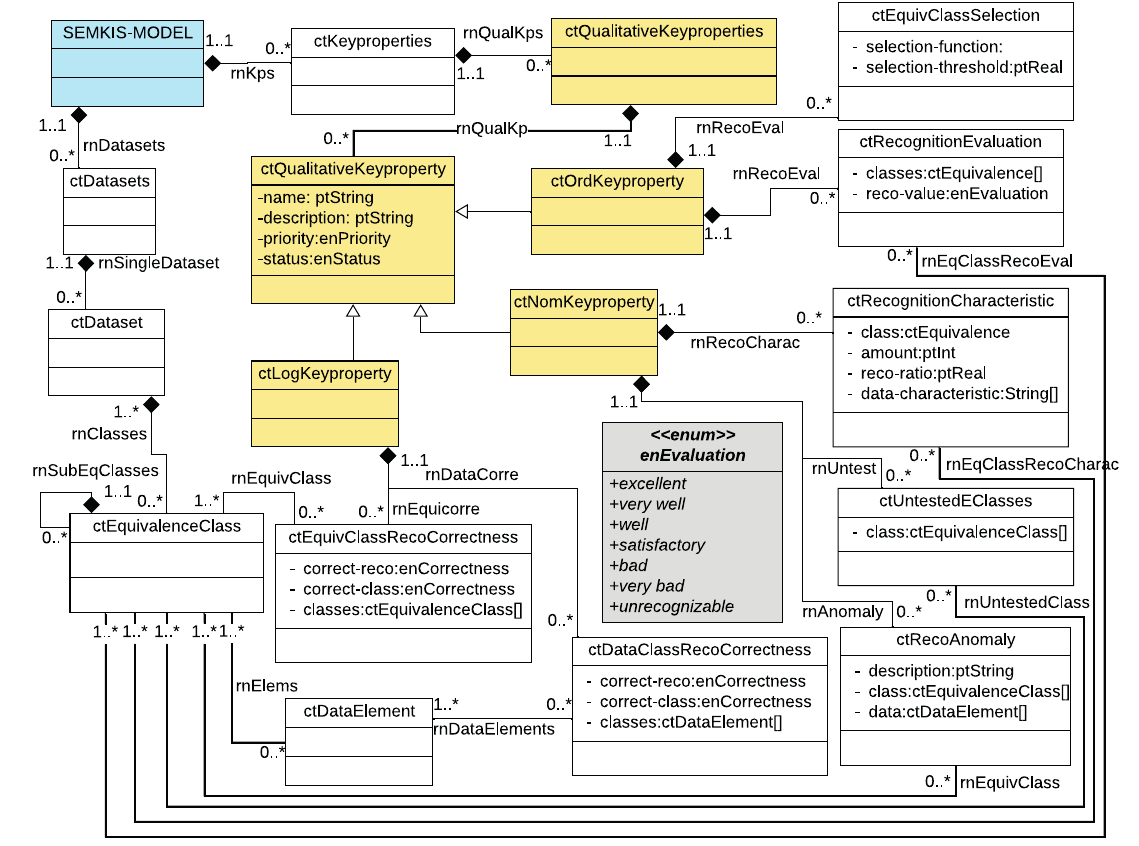
Figure 6. SEMKIS-DSL Metamodel: Qualitative key-properties specification